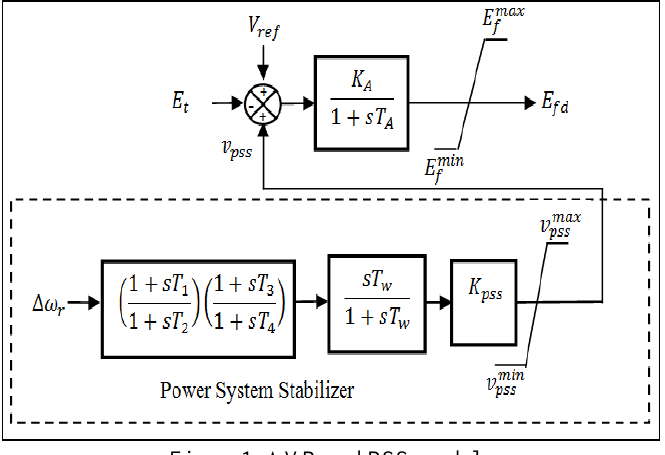
Figure 1: AVR and PSS